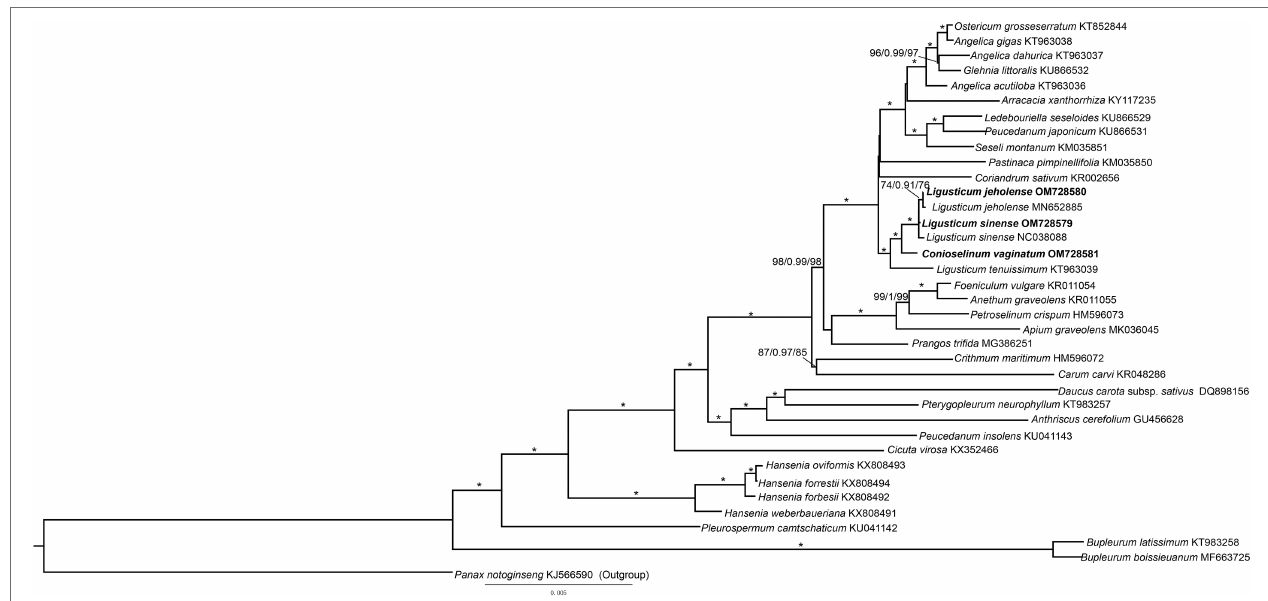
FIGURE 8 | Phylogenetic tree of Apiaceae obtained from the maximum likelihood (ML) analysis of chloroplast genomes. Numbers on branches are support values (BS ML /PP BI /BS MP ), Stars indicate BS MP , BS ML = 100%, and PP BI =